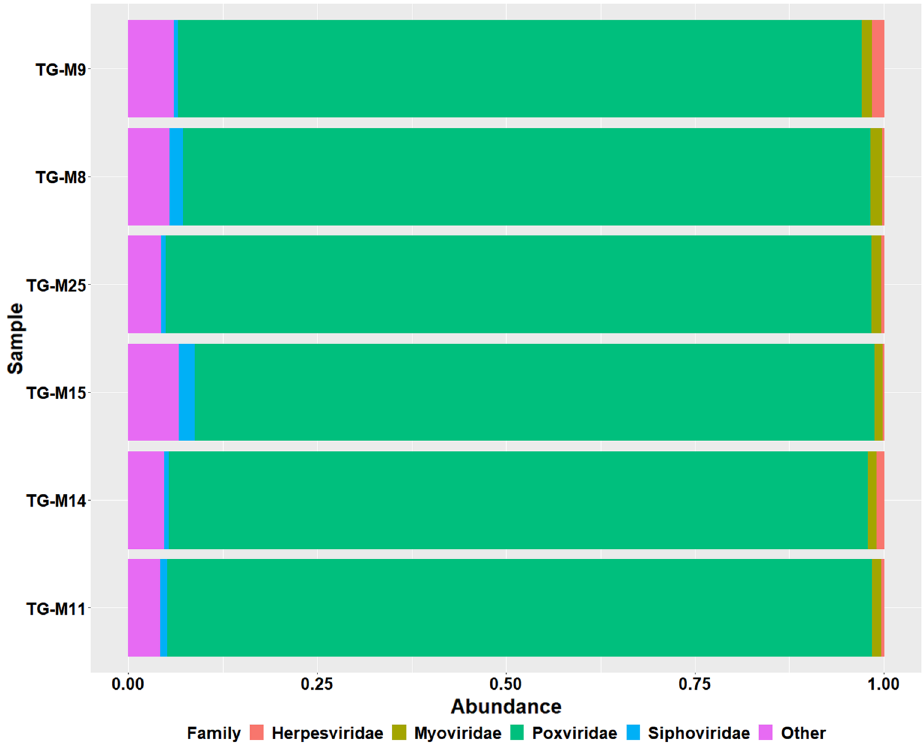
Figure 5. Bar plots showing the most abundant of viruses at a family level; the most prevalent families were as follows: (i) Poxviridae (indicated in bright green), (ii) Siphoviridae (indicated in blue), (iii) Myoviridae (indicated in olive green) and (iv) Herpesviridae (indicated in red). The rest of the viruses are grouped together as other (indicated in